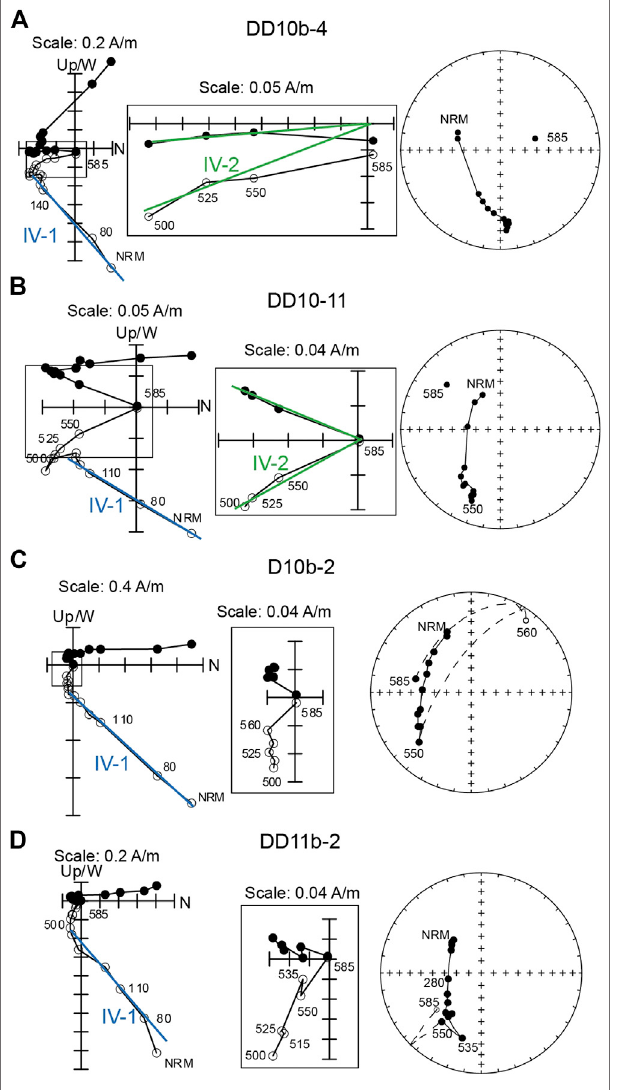
FIGURE 6 | (A – D) Representative orthogonal plots (Zijderveld, 1967) of stepwise thermal demagnetization behavior of Emeishan basalt unit IV. Symbols are the same as in Figure 6